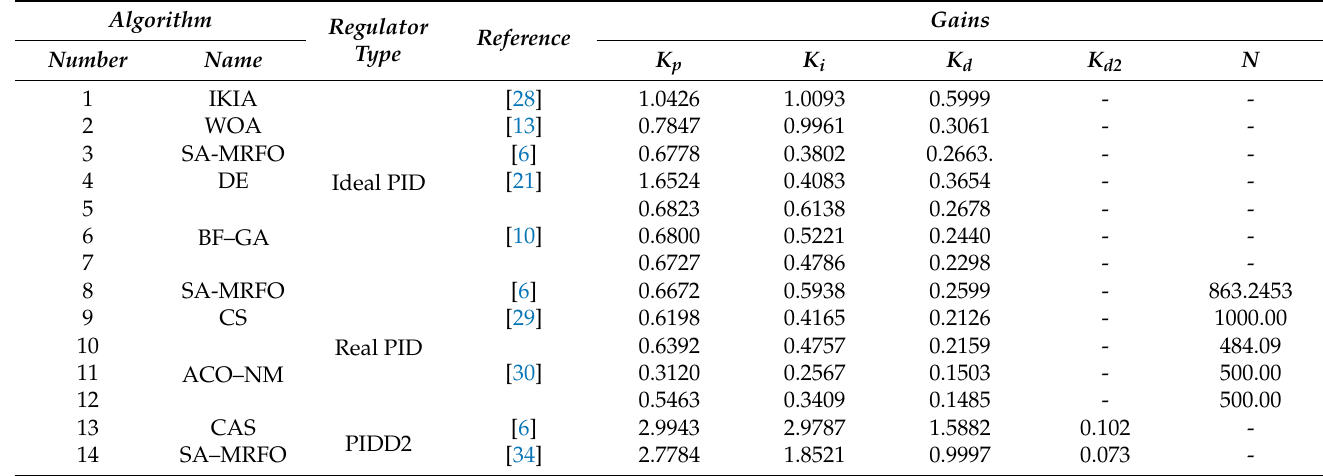
Table 5. Review of the optimal parameters of the